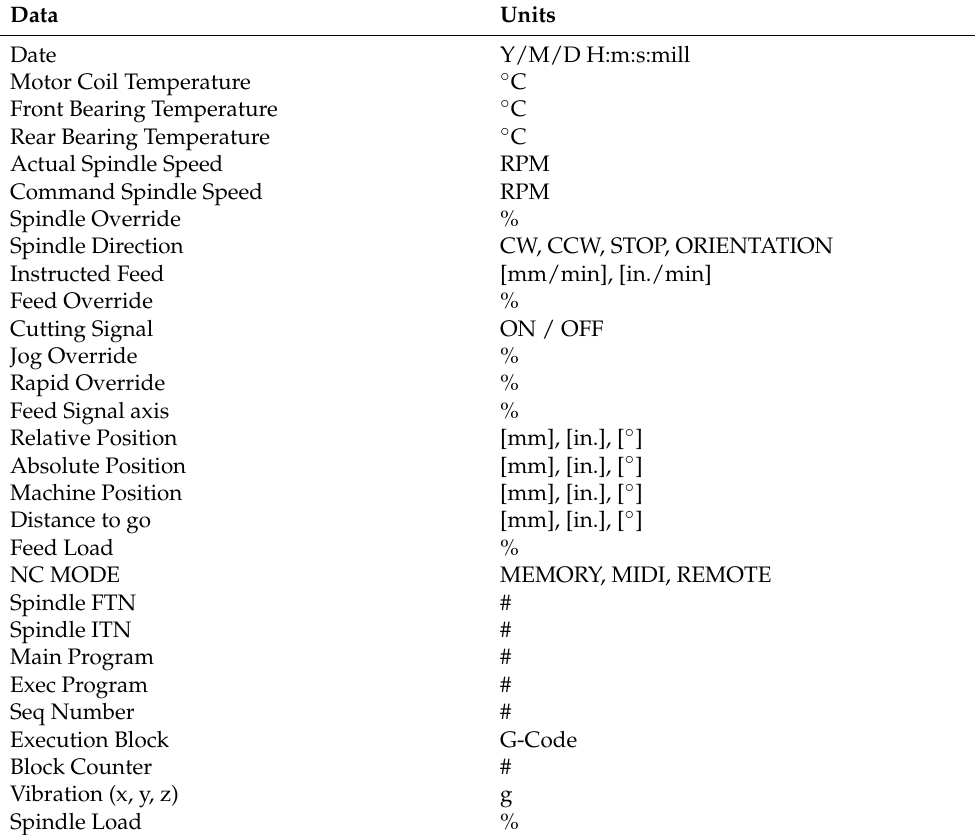
Figure 2. High level diagram of a machining program for complex parts manufacturing used by our industrial partner. Table 1. Parameters extracted from the Computer Numerical Control (CNC) machine tools’ controller.